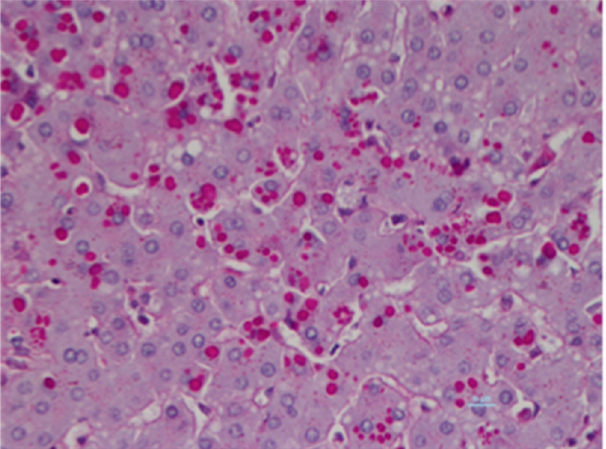
Figure 1. Z-alpha 1 antitrypsin (Z-AAT) aggregates in Inclusion Bodies. Human ZZ liver biopsy stained with hematoxylin-eosin and periodic acid-Schiff- (PAS)-Diastase digestion. The PAS-Diastase stains glycoproteins and consequently Z-AAT inclusion bodies in red.